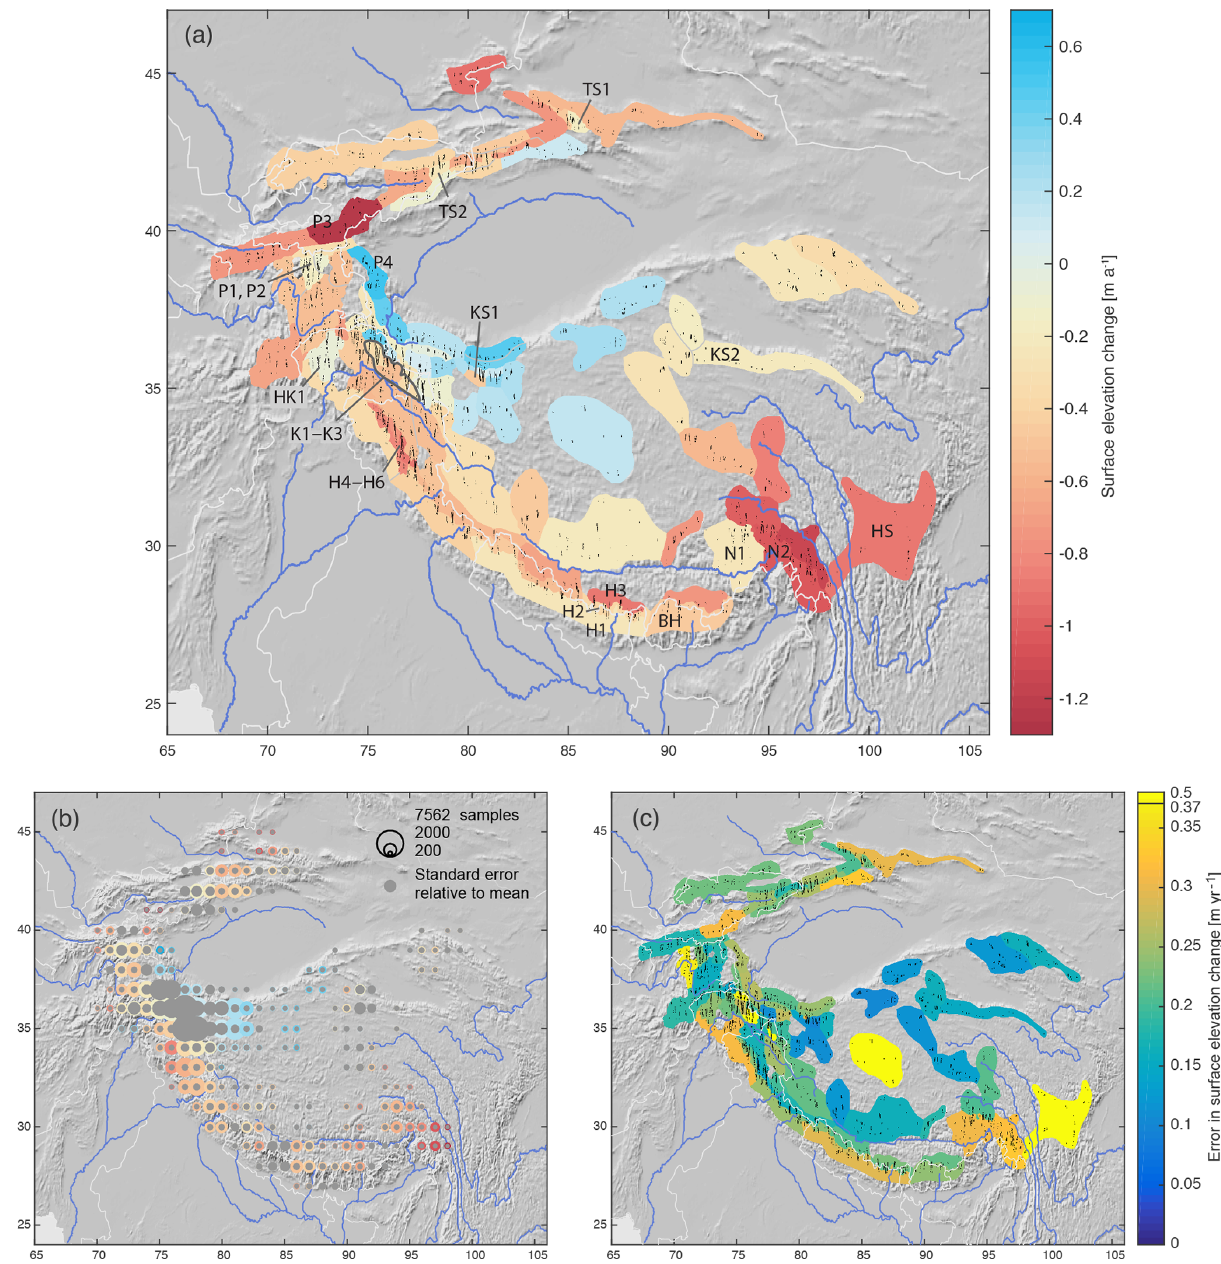
Figure 2. The 2003–2008 glacier elevation change rates for (a) manually delineated zones and (b) overlapping 2 ◦ × 2 ◦ degree grid cells with 1 ◦ spacing. Colour bar (b) as in (a) . Circles in (b) are scaled according to sample numbers. The overlaid grey circles show the standard error in relation to the slope of the linear fit; i.e. elevation change is not significantly different from zero (at 1 σ ) where the coloured circles are fully covered. (c) Error for (a) at 1 σ , including uncertainties from deviations from the standard method, December 2008 snowfall correction, and trends in off-glacier samples. The four bright yellow units have uncertainties between 0.43 and 0.50ma − 1